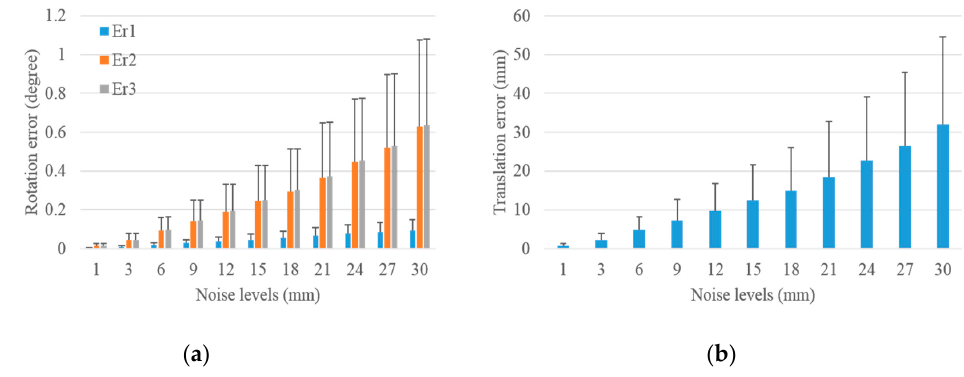
Figure 8. Rotation and translation errors for the extrinsic calibration of LRF with respect to the control field under increasing range noise levels. ( a ) Rotation error and ( b ) translation error.